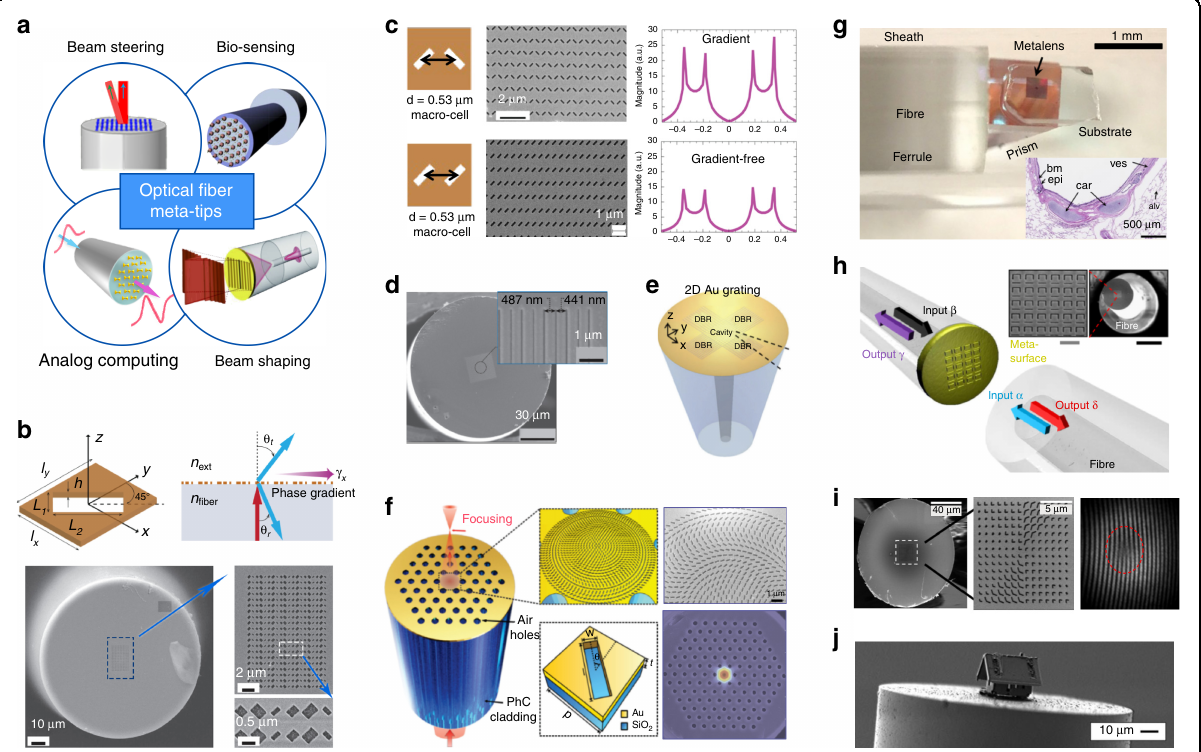
Fig. 5 Optical fi ber meta-tips. a Combining the advantages of optical fi bers and the functionality of metasurfaces for novel devices. Insets adapted from: Elsevier (Bio-sensing 255 ); AIP publishing (Beam shaping 256 ). b Schematics and SEM images of an optical fi ber meta-tip for beam steering 75 . c Upper panels: Metasurface-enhanced lab-on- fi ber bio sensors. Lower panels: Gradient-free benchmark 76 . d SEM images of the fi ber facet-integrated metamaterial dispersive gratings 107 . e Multiparameter nanoprobe using a plasmonic crystal cavity on fi ber end-face 254 . f Metalens on photonic crystal (PhC) fi ber facet: schematics and SEM images of the meta-structures 100 . g Photograph of the nano-optic endoscope using metalens 74 . Inset: In vivo endoscopic imaging. h Fiber-optic meta-device for all-optical signal modulation 96 . i SEM image of meta-facet fi ber to generate OAM + 1 with measured tilt interferogram 257 . j SEM image of a tiny microhouse assembled on a fi ber tip 260 . Figures adapted from: Springer Nature ( b 75 , e 254 , g 74 , h 96 ); Wiley ( c ) 76 ; AIP ( d 107 , i 257 , j 260 ); De Gruyter ( f ) 100